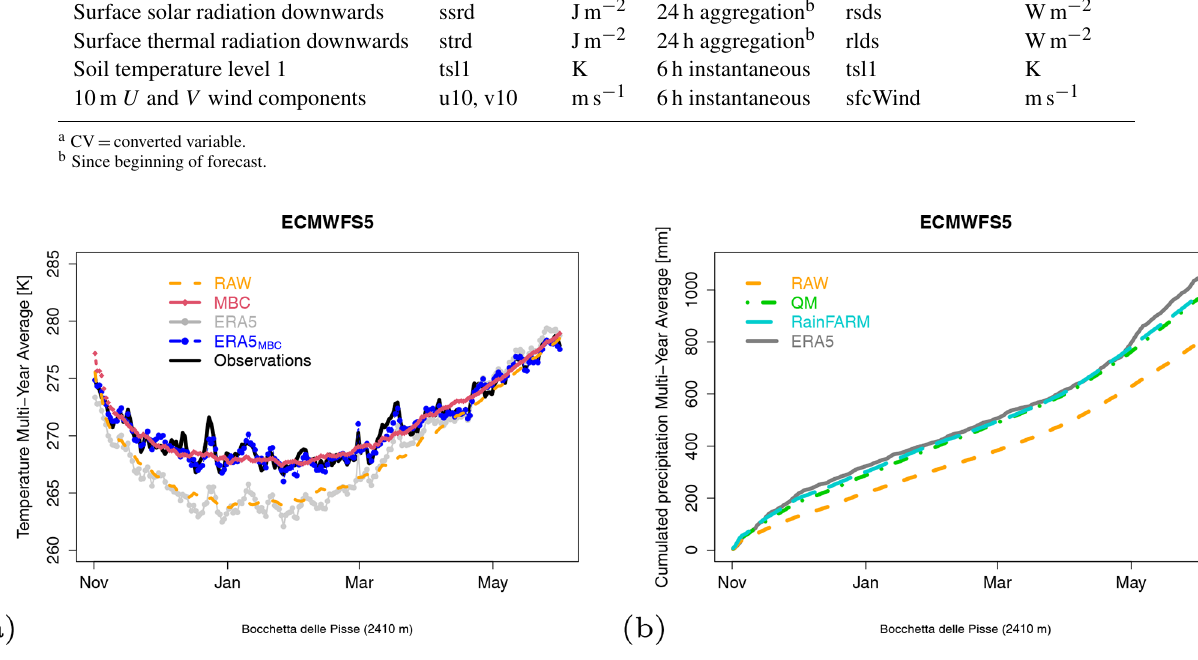
Figure 2. Multi-annual (1995–2015) averages at the Bocchetta delle Pisse station (2410ma.s.l.) of (a) daily air temperature in (grey) the ERA5 reanalysis, (blue) the ERA5 reanalysis after the bias correction with respect to observations with the MBC method, (orange) the ECMWFS5 seasonal forecasts, (red) the ECMWFS5 seasonal forecast after the bias correction with respect to observation with the MBC method, and (black) observations, as well as (b) accumulated total precipitation in (grey) the ERA5 reanalysis and in the ECMWFS5 seasonal forecasts with different levels of post-processing (green) after the bias correction with the quantile mapping method with respect to ERA5, (cyan) after the bias correction and the downscaling with the RainFARM method adapted for complex